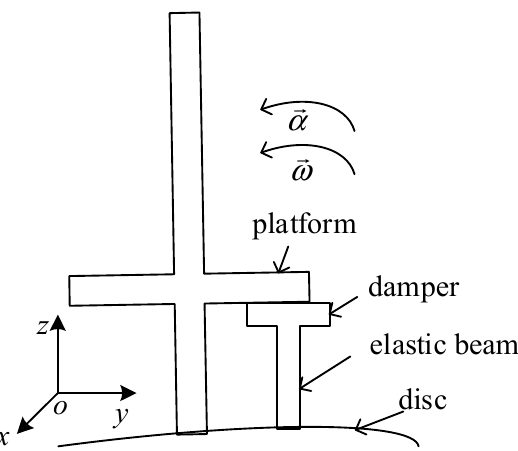
Figure 1. Structure of blade with under-platform damper.